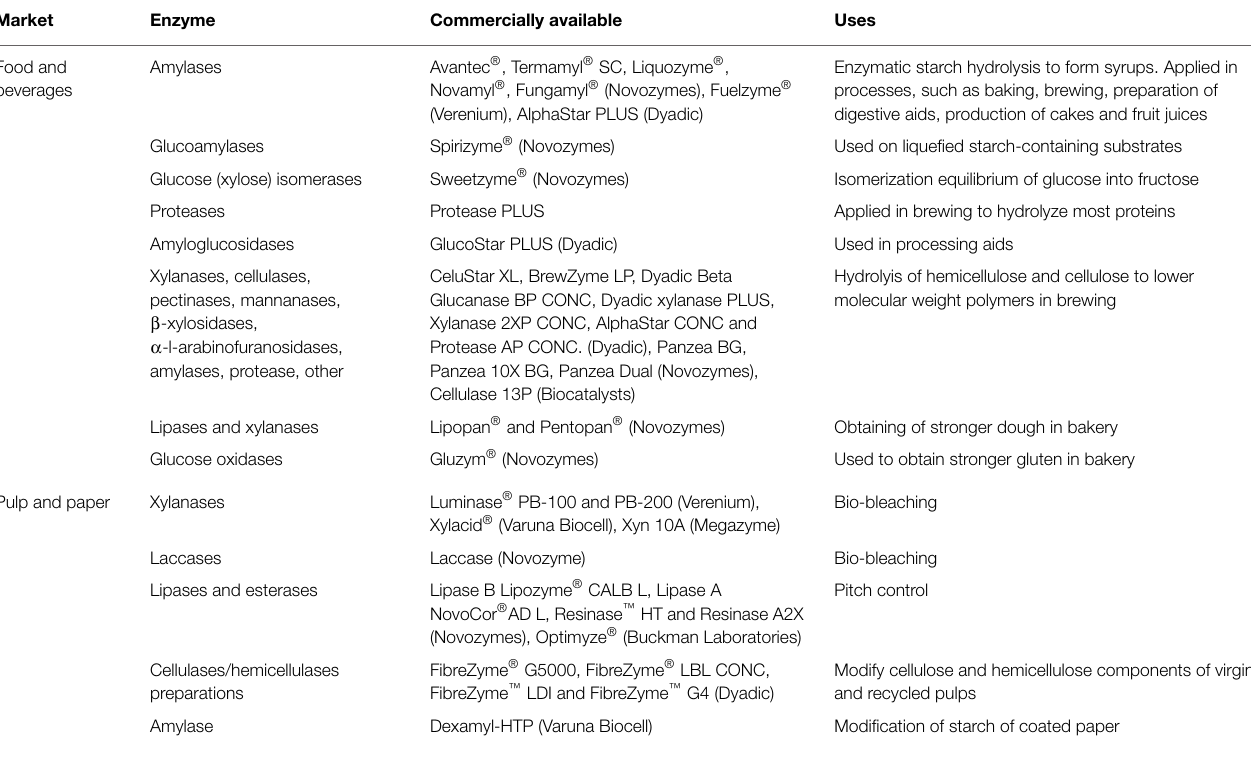
TABLE 2 | Examples of commercially available thermostable enzymes .